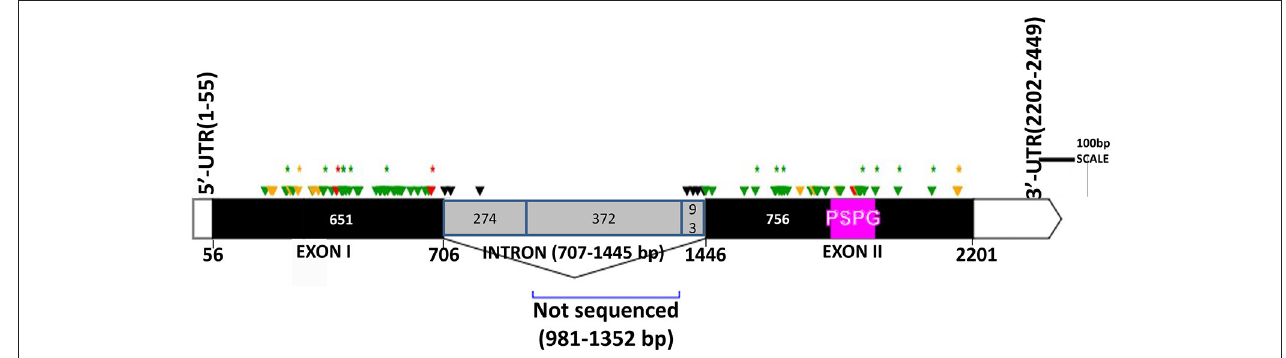
FIGURE 2 | Distribution of EMS-induced mutations within the flax UGT74S1 . UTRs are indicated by blank boxes, exons by solid black boxes, and the intron by a gray box. The PSPG region within exon 2 is colored in magenta. Green arrows, missense mutations; yellow arrows, sense mutations; red arrows, nonsense mutations; black arrows, mutations in intron; asterisks (*) indicate position of homozygous mutations only; Numbers are in bp and the starts and ends of exons are indicated in bp.